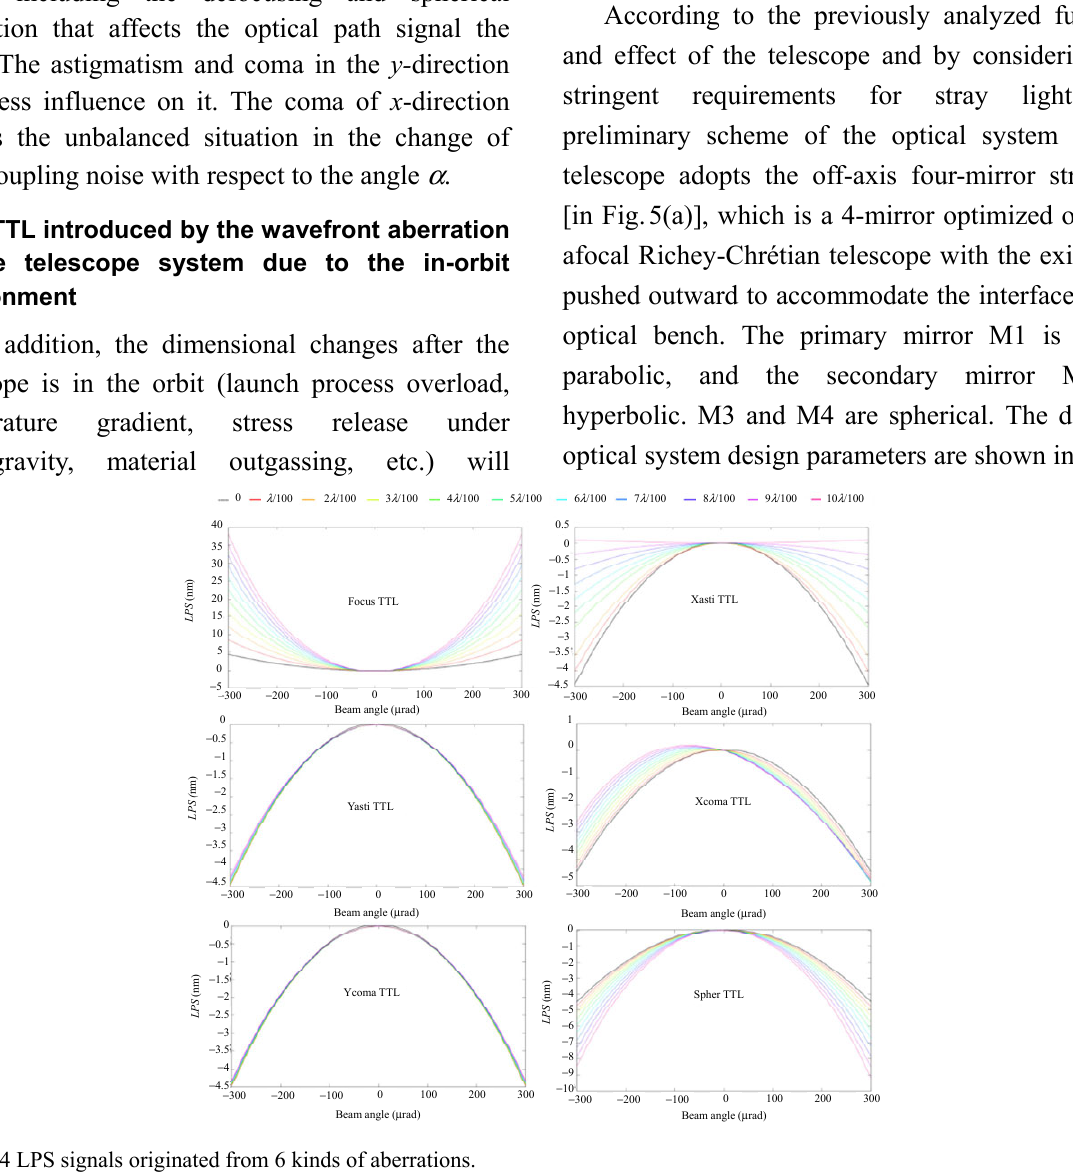
Fig. 4 LPS signals originated from 6 kinds of